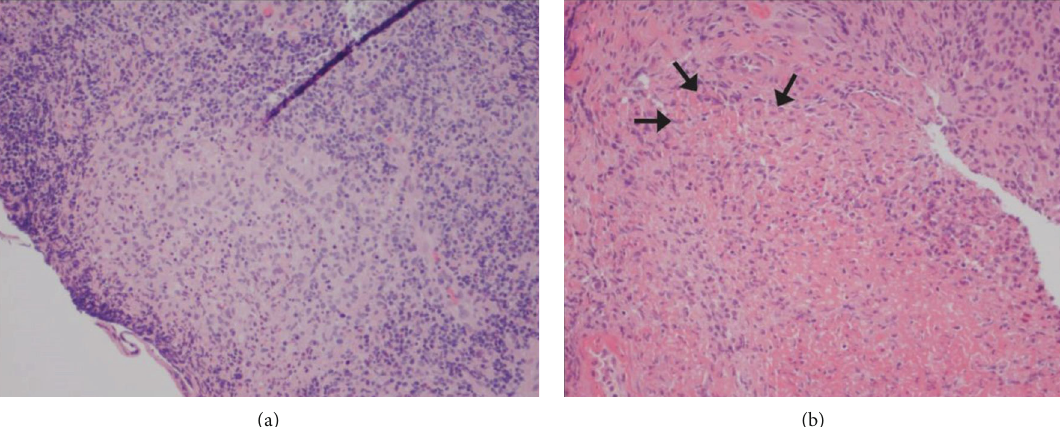
Figure 10: H&E stain of an ileal mucosal biopsy (a) and cecal mucosal biopsy (b) demonstrating histiocyte-rich granulomatous changes with central necrosis (arrows) in a patient diagnosed with granulomatous ileitis due to typhoid fever. (Images obtained with permission from Cheung et al. [67]).